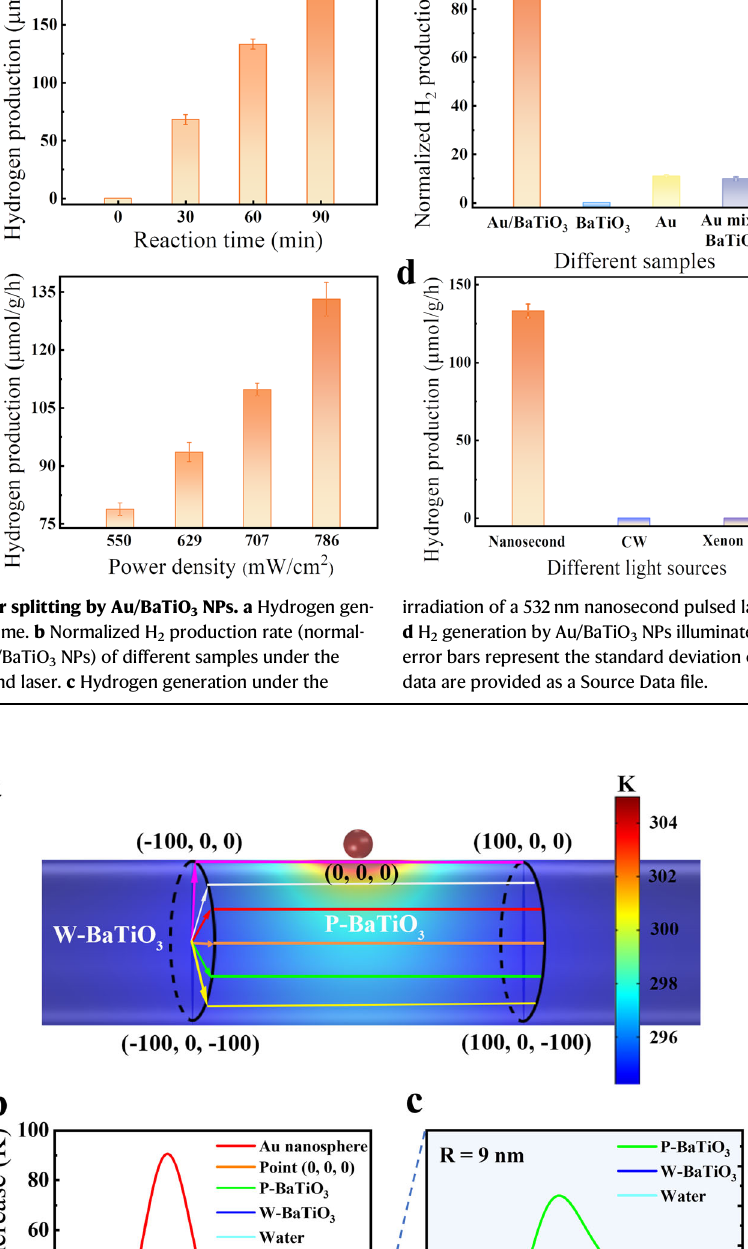
NP,regionofP-BaTiO 3 ,regionofW-BaTiO 3 ,andsurroundingwater. c Enlargedtime evolution of the average temperatures of the regions of P-BaTiO 3 , W-BaTiO 3 , and surrounding water. Source data are provided as a Source Data fi le.